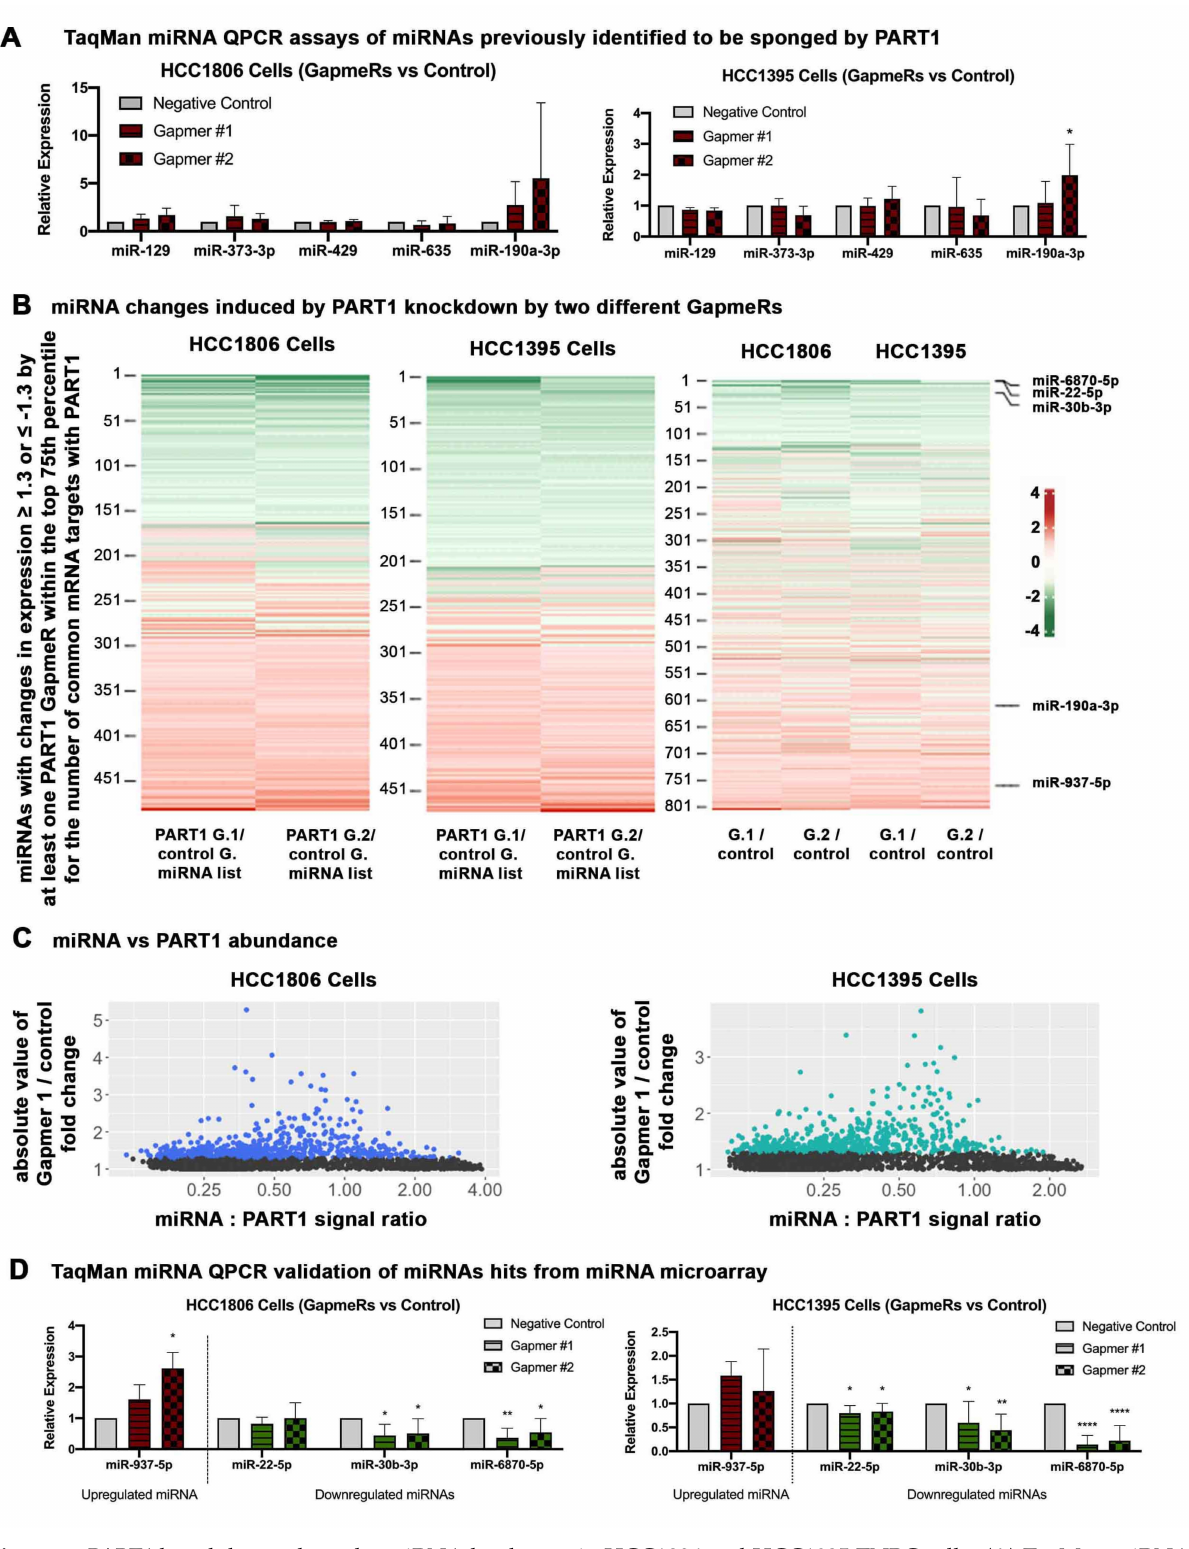
Figure 5. PART1 knockdown alters the miRNA landscape in HCC1806 and HCC1935 TNBC cells. ( A ) TaqMan miRNA assays of miRNAs previously implicated as being sponged by PART1 in non-breast cancer cells were assessed in HCC1806 and HCC1935 cells with or without GapmeR-induced knockdown of PART1 (Gapmer1 (G.1) or Gapmer2 (G.2) versus control GapmeR (control G.) ( n = 4–8, significance determined by one-way ANOVA, followed by Dunnett’s post-test for multiple comparisons). Error bars represent SD. miR-129 , miR-373-3p , miR-429 and miR-635 levels were quantified by the TaqMan miRNA assays and the expression is normalized to reference miRNAs RNU48 and miR-221 . miR-190a-3p